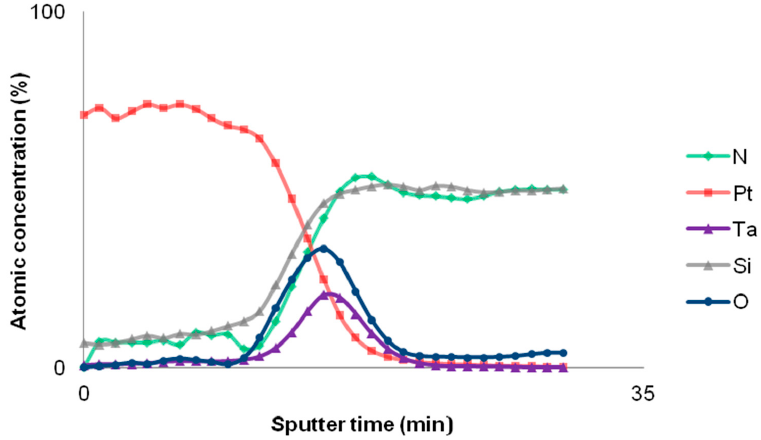
Figure 7. Depth profile analysis of the resistor performed by X-ray Photoelectron Spectroscopy (XPS). The atomic concentrations are reported as a function of sputter time.